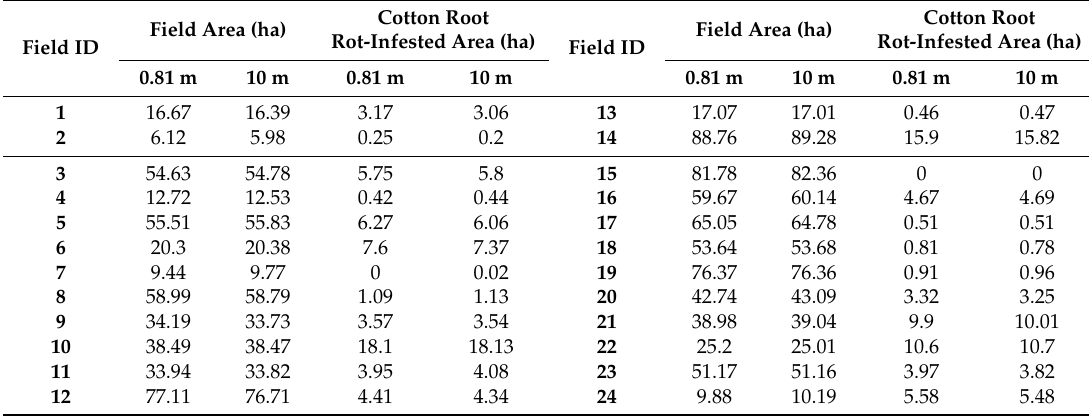
Table 1. Comparison of cotton root rot-infested areas for 24 cotton fields between the 0.81 m airborne image classification maps and resized 10 m classification map.